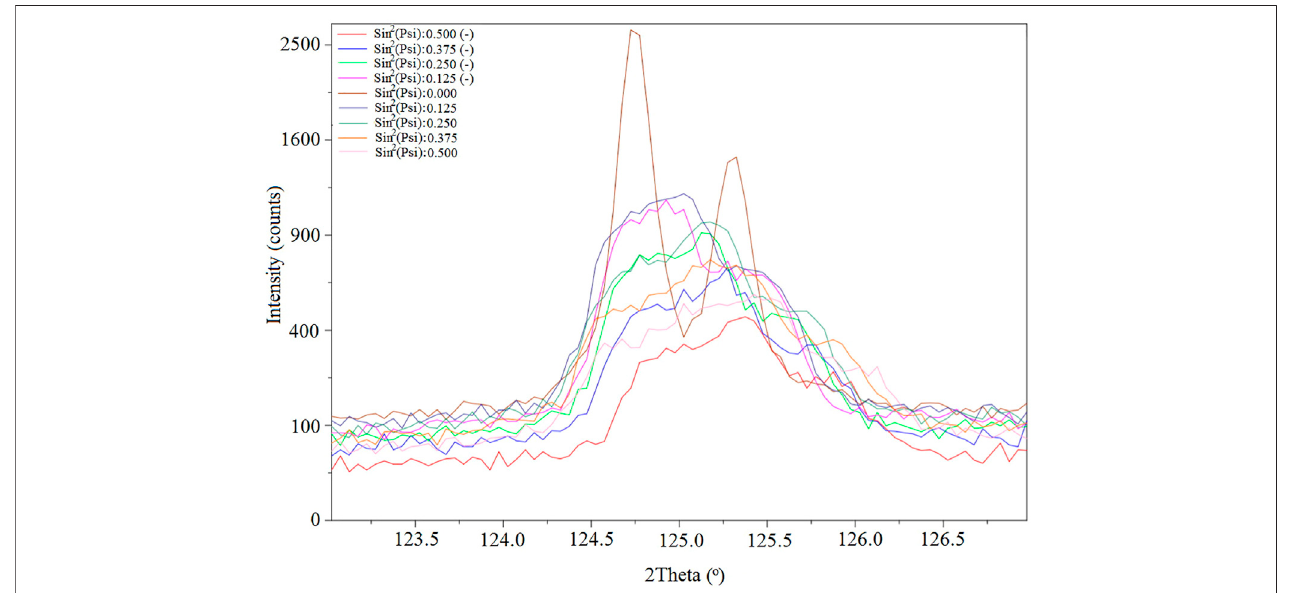
FIGURE 8 | X-ray diffraction pattern of sample C1 at different ψ .